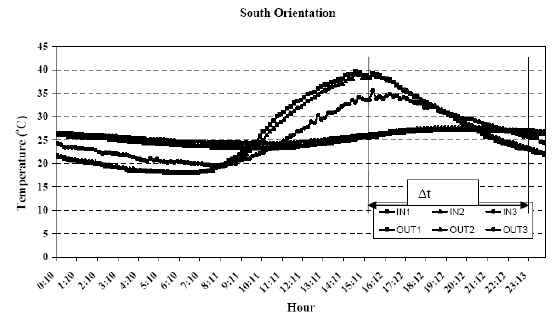
Figure 11. Temperature distribution inside and outside at south wall Summer period